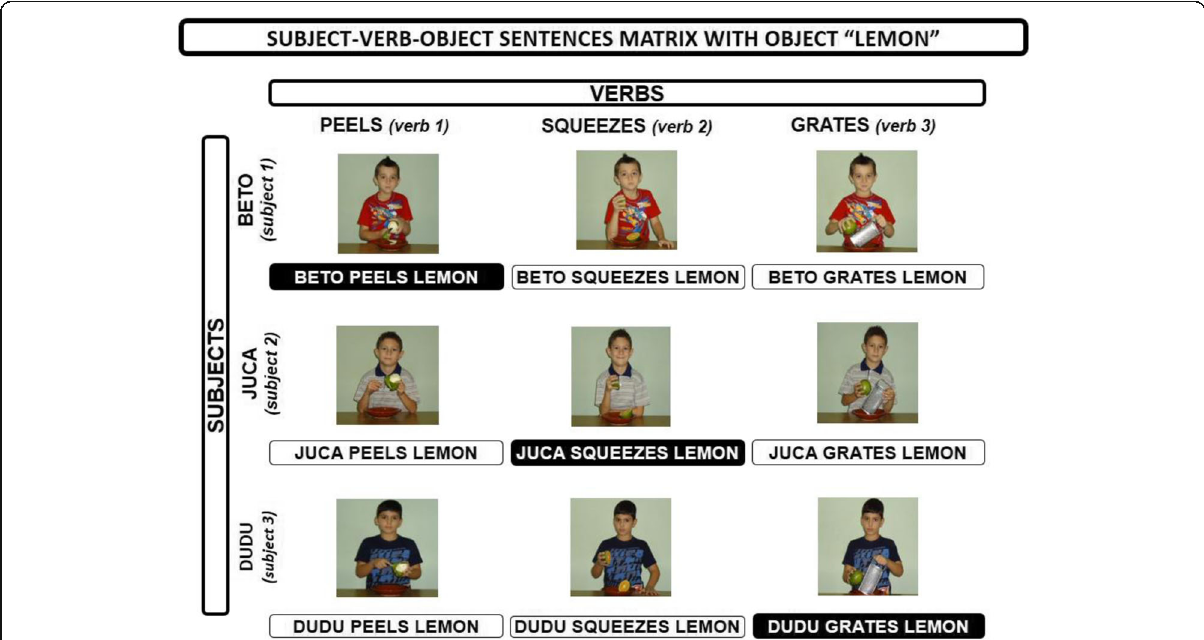
Fig. 1 3 × 3 training matrix. The combination of the components in the rows (subjects), columns (verbs), and the constant object in the matrix generate nine subject-verb-object (S-V-O) sentences. The three diagonal sentences were directly taught (black box). The others six sentences in the matrix were tested (white